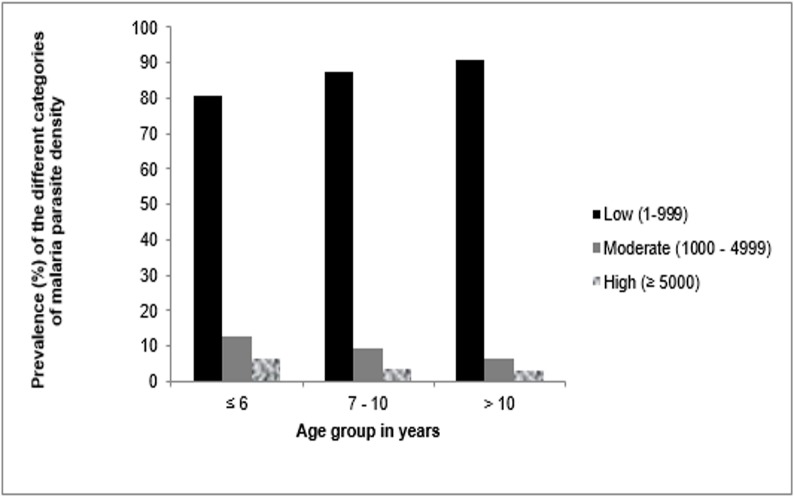
Variation in prevalence of the different categories of parasite densities in the different age groups.